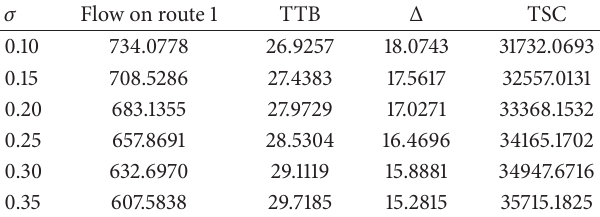
Table 8: Results with different 𝜎 at RUE.